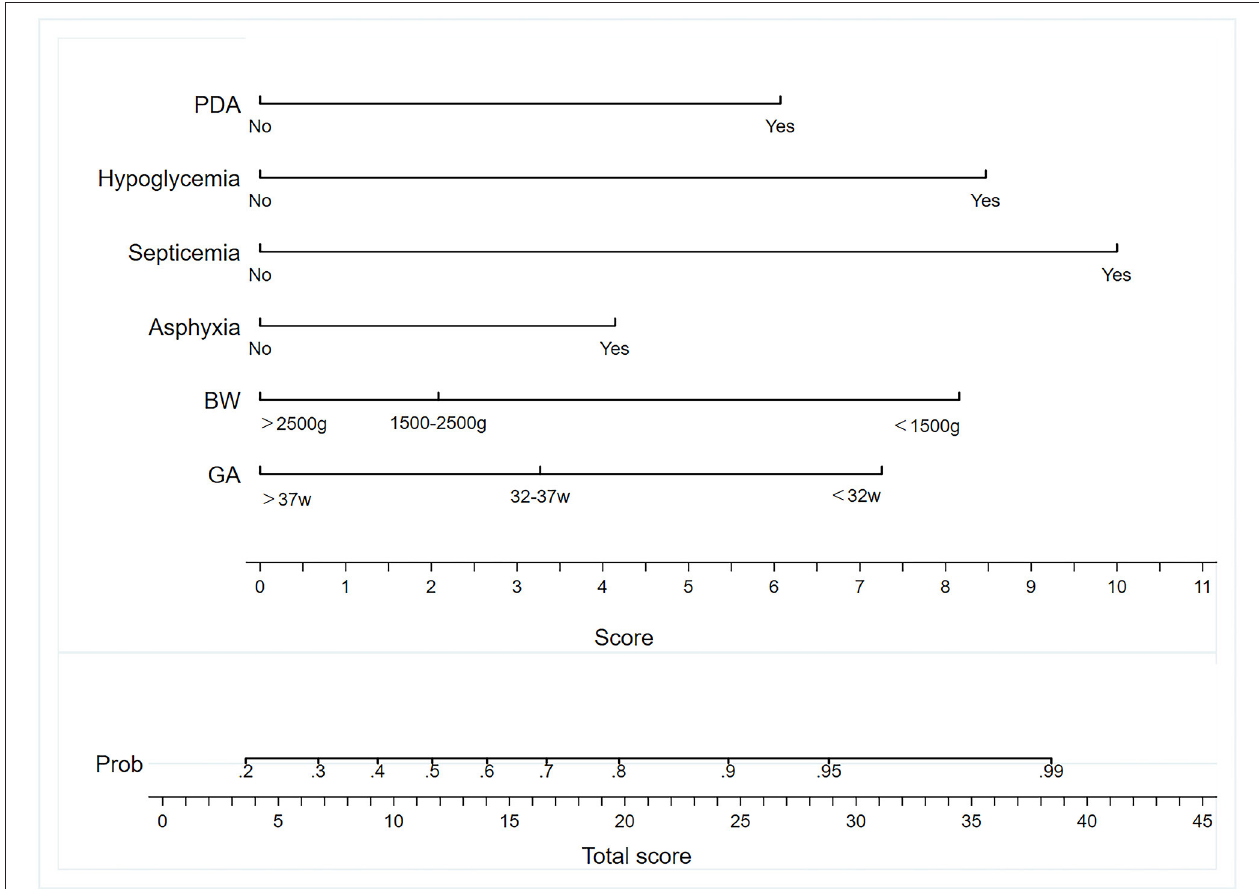
FIGURE 2 | Nomogram to predict the incidence of NEC. BW, birth weight; GA, gestational age; PDA, patent ductus arteriosus.